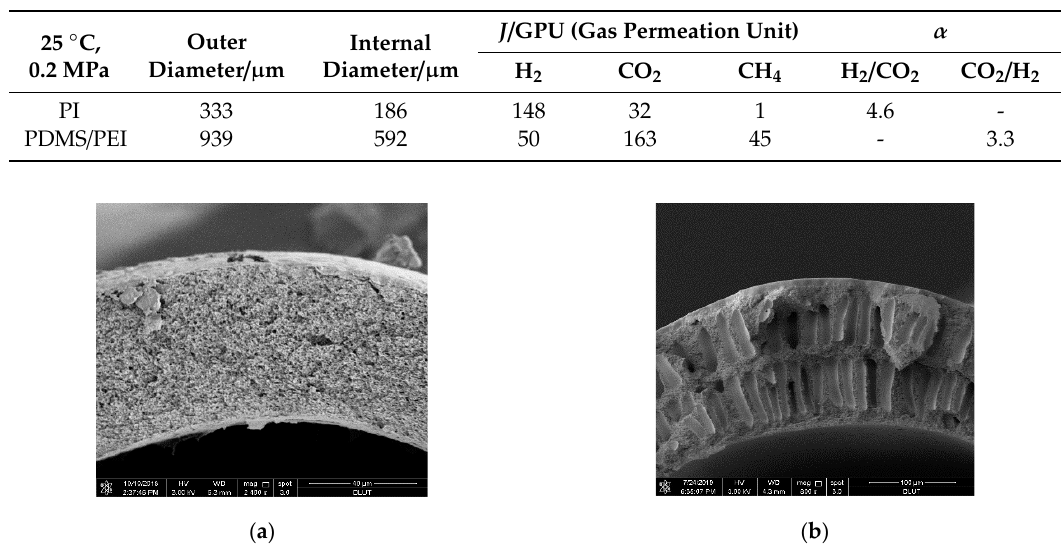
Table 1. Performance parameters of polyimide (PI) and polydimethylsiloxane/polyetherimide (PDMS/PEI) hollow fiber membranes.